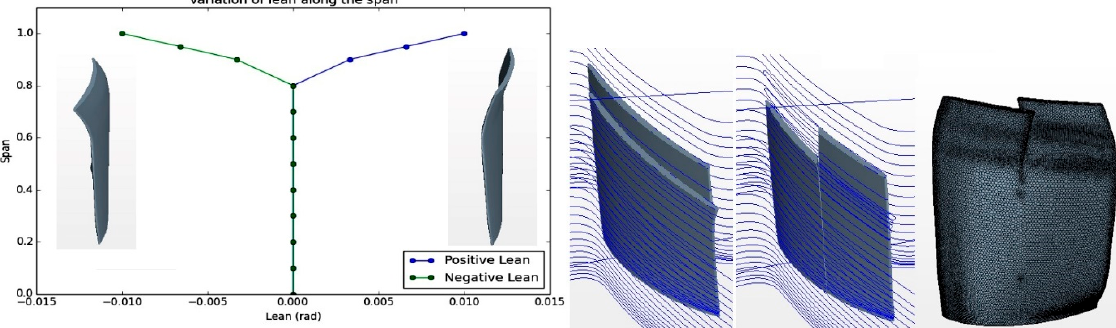
Figure 21. Local lean defined in both directions near the tip and merged to create a split tip.